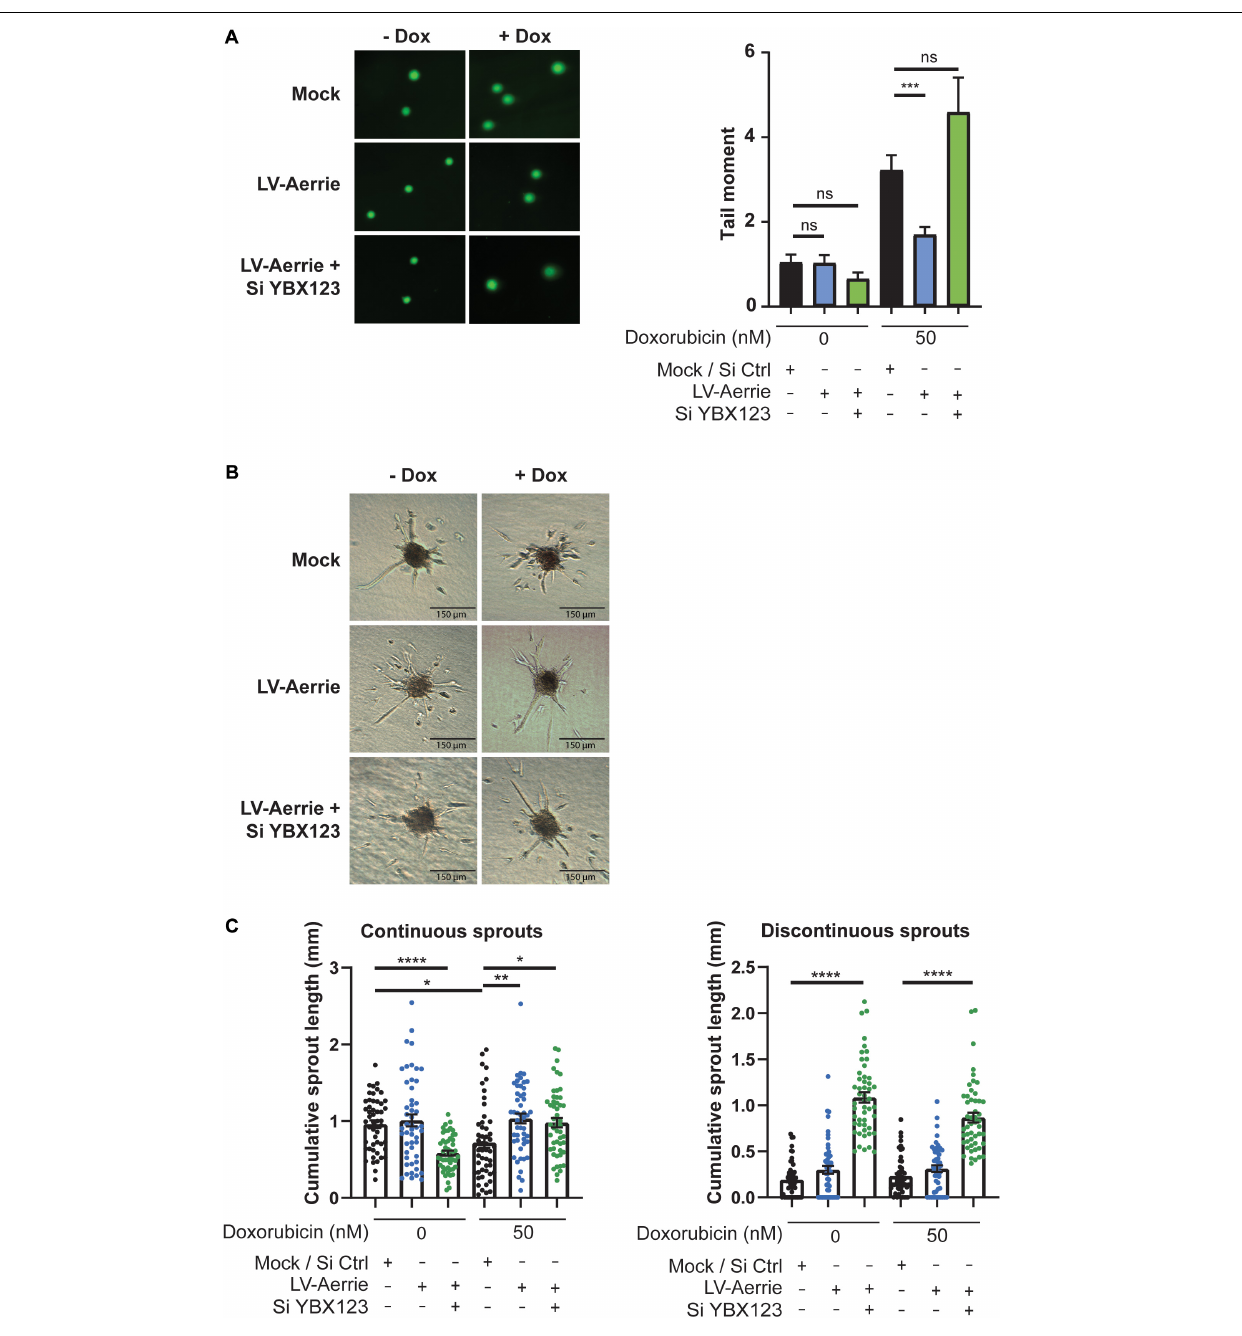
FIGURE 6 | Overexpression of Aerrie improves DNA repair and angiogenic sprouting and is impaired by loss of YBX1/2/3. (A–C) HUVECs were treated with lentivirus (LV) for Aerrie overexpression and siRNA (si) targeting YBX1/2/3 or a respective control. (A) HUVECs with depleted Aerrie or YBX1 are stimulated with Doxorubicin (50 nM) and embedded in low melting agarose stained with SYBR gold and imaged by fluorescence microscopy. Comets were quantified by CometScore. ( n > 3, at least 50 comets per experiment) (B) Sprouting assay performed with or without stimulation of Doxorubicin (50 nM). (C) Quantification of the continuous and discontinuous sprouts per condition. Measured by the distance from the tip cell to the stalk cell. ( n = 3, ≥ 10 spheroids per experiment). * p < 0.05; ** p < 0.01; *** p < 0.001; **** p < 0.0001; ns , not statistically